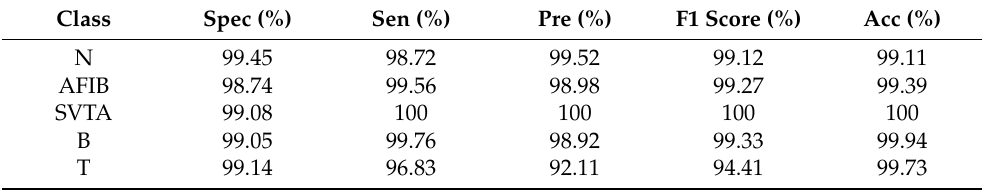
Table 3. Performance of classification model for ECG rhythms with a small number of